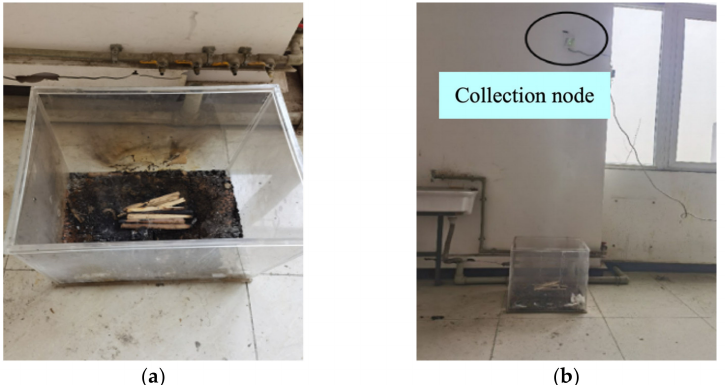
Figure 15. The beech wood smolder test: ( a ) the process of beech wood combustion; ( b ) the smol- der scene.